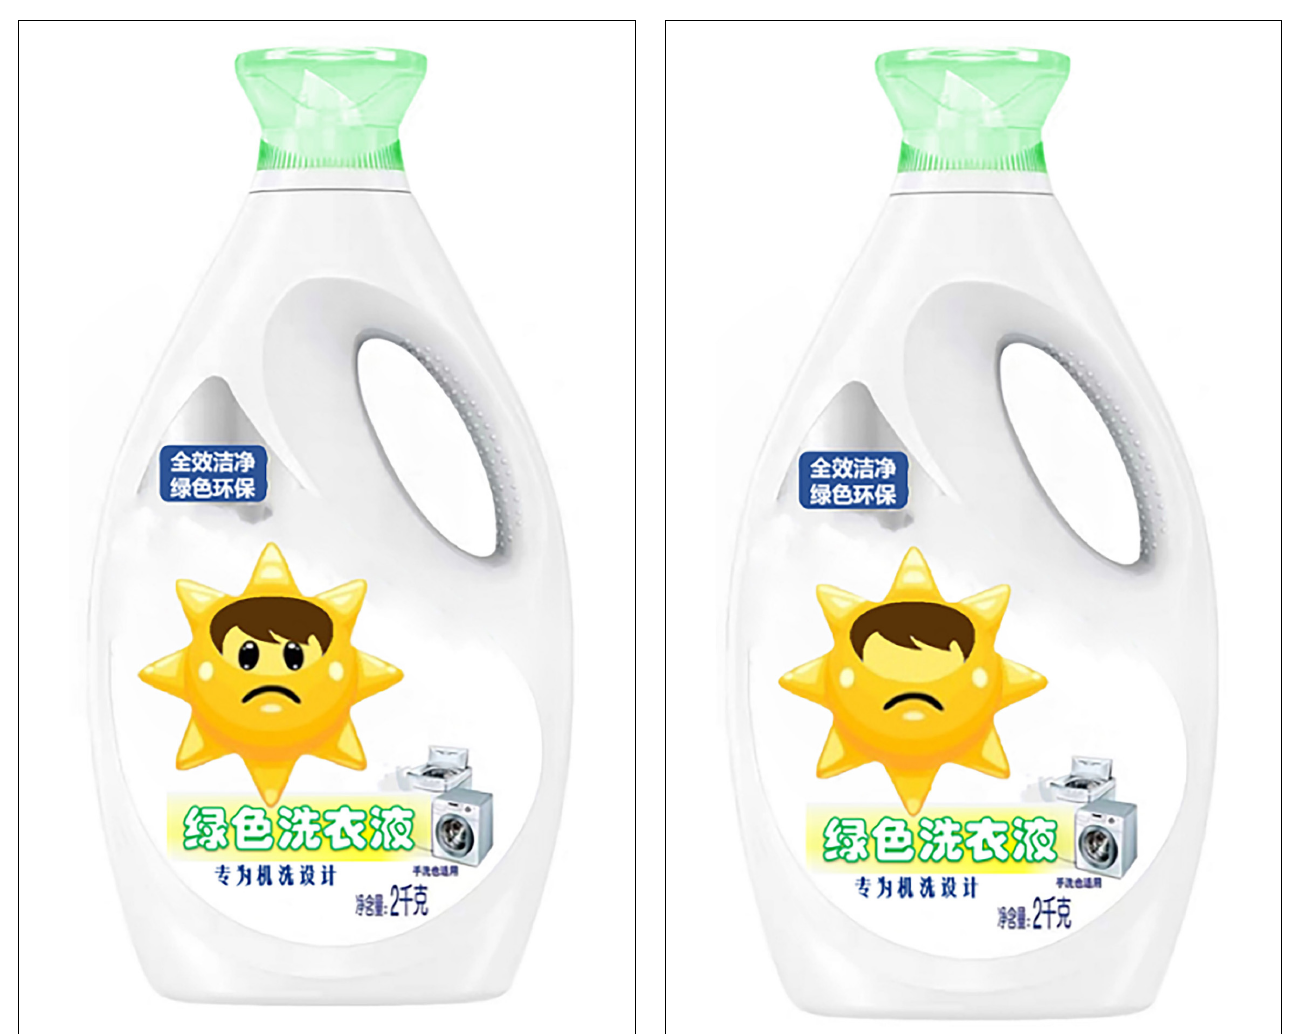
FIGURE 9 | Anthropomorphic strategy of sad expressions without